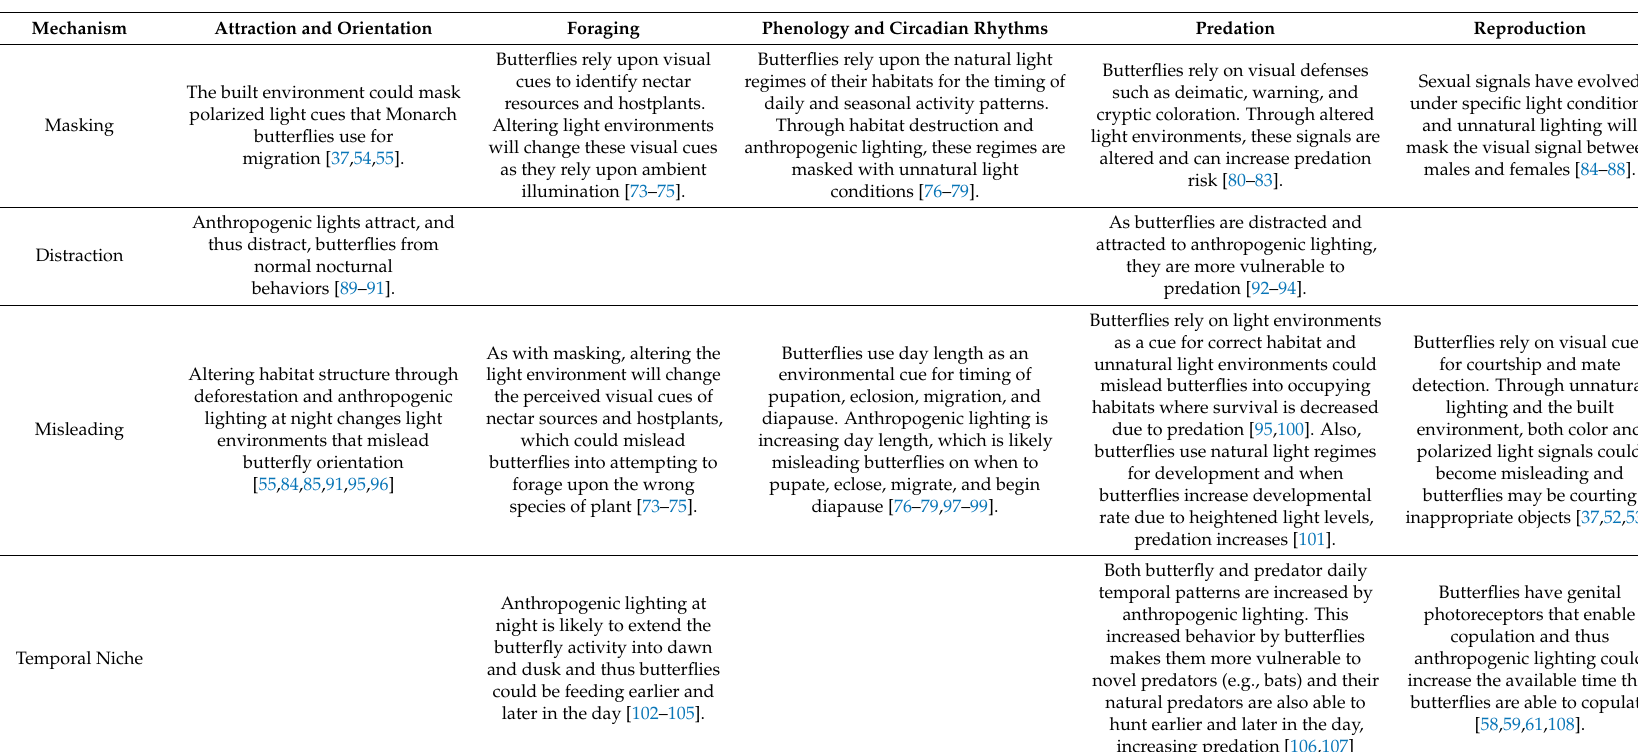
Table 1. Mechanisms and biological functions. The four mechanisms with the five butterfly behaviors are listed here with the most pertinent sources. Blank boxes represent biological functions that are likely not affected by the specific